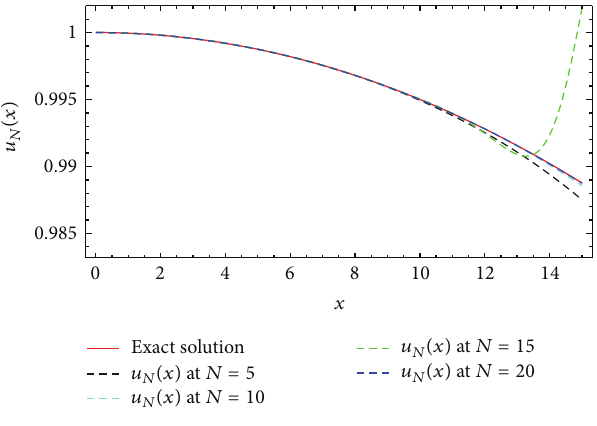
Figure 10: Comparing the exact and approximate solutions at 𝑁 = 5 , 10, 15, and 20, where ] = 3/4 , 𝛼 = 2 , and 𝛽 = 2